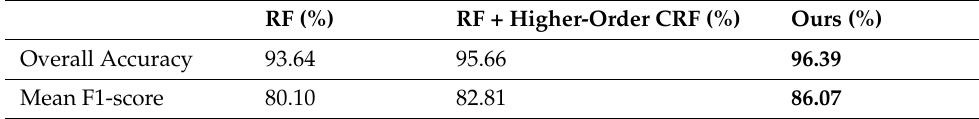
Table 9. Overall accuracy of the proposed method in different steps.